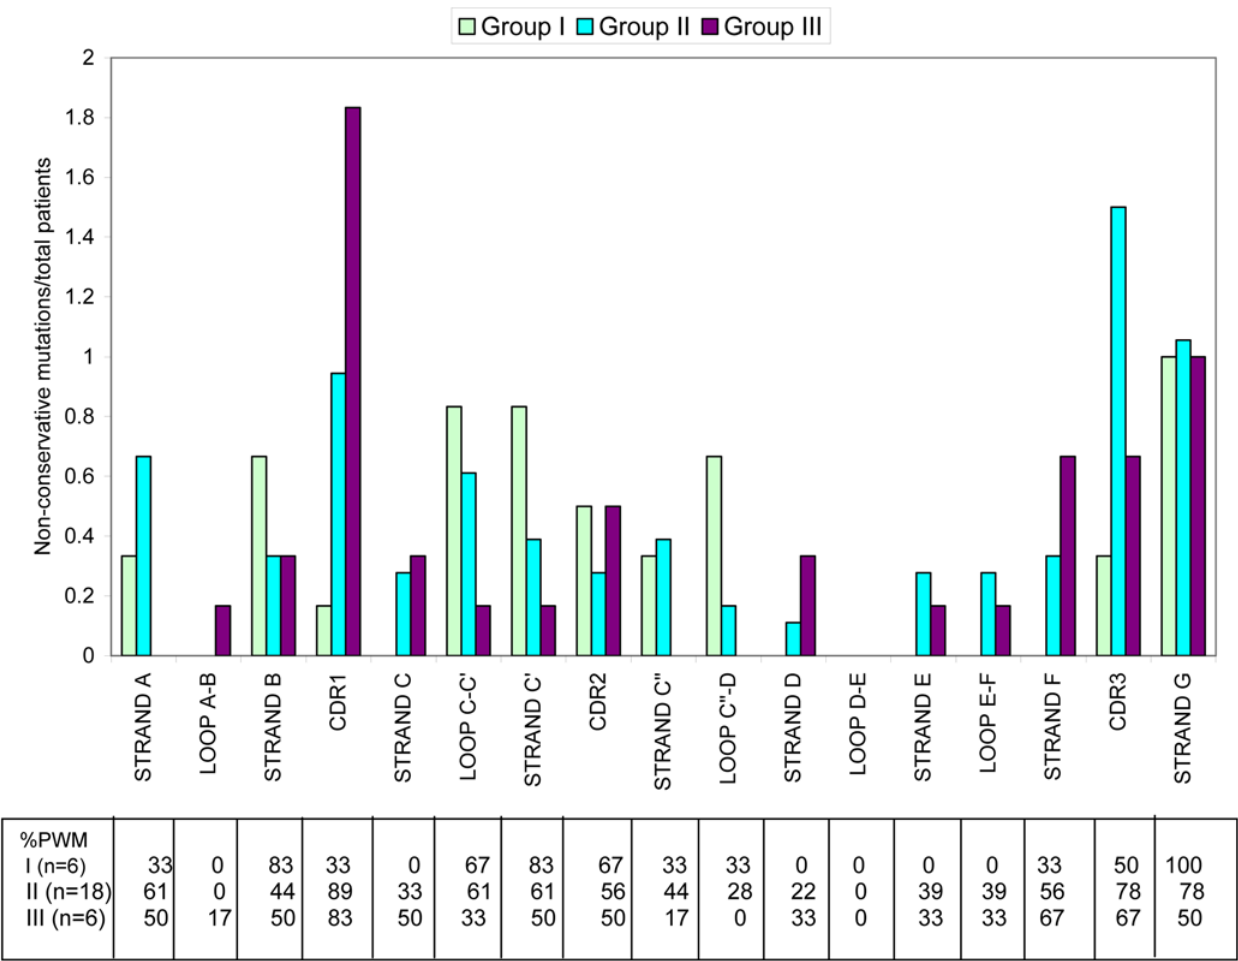
Figure 5. Comparison of non conservative mutations per total number of patients for low (I), medium (II) and high (III) iFLC levels in selected Mayo proteins per secondary structure. iFLC levels have been shown to be a good clinical parameter to follow disease progression [15,18]. The sequences were gathered into three groups based on their iFLC levels at the time of diagnosis. Whenever there is no data shown for a particular group/secondary structure element, the value is zero. The secondary structure boundaries used were based on the germline donor for each protein. Numbering is based on Kabat (http://vbase.mrc-cpe.cam.ac.uk/). The %PWM in each secondary structure element is listed per group.